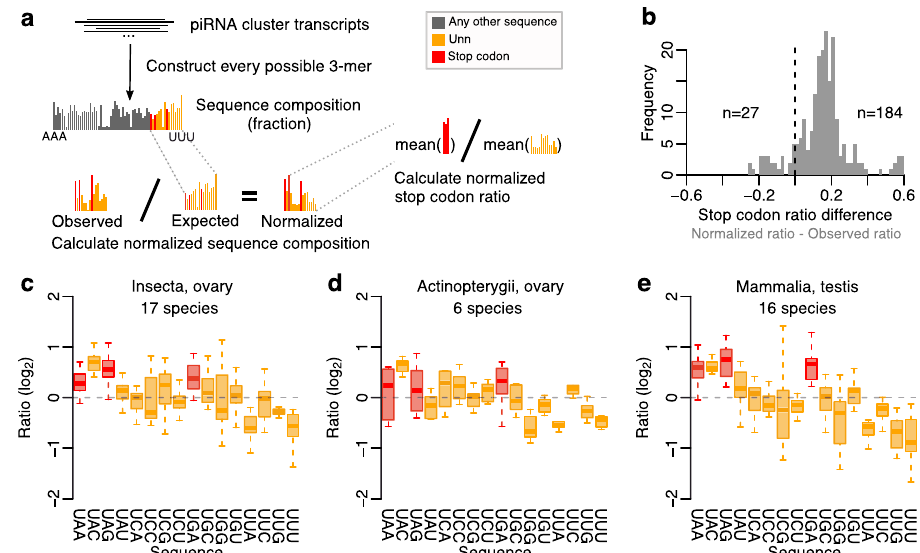
Fig. 7 Stop codon enrichment is independent of piRNA cluster sequence composition. a Schematic to illustrate the data processing. First, piRNA cluster transcripts are used to construct the expected piRNA 5 ′ end sequence distribution. Second, the observed piRNA 5 ′ end sequence composition is divided by the expected sequence distribution to construct the normalized sequence composition. Third, stop codon ratio is calculated based on the normalized sequence composition. b Histogram showing the difference in stop codon ratio with or without normalization to the piRNA cluster composition. See also Supplementary Fig. 10a – b for normalized ratios and differences per library. c – e Boxplots showing ratio between observed and expected fraction of Unn sequences in insect ovary ( c ), ray- fi nned fi sh ovary ( d ), or mammalian testis ( e ). Each species is represented as one data point in the boxplots, and multiple libraries from the same species were averaged. The three largest groups are shown here, see also Supplementary Fig. 11. Boxplots show median (central line), interquartile range (IQR, box), and minimum and maximum values (whiskers, at most 1.5*IQR). Source data are provided as a Source Data fi